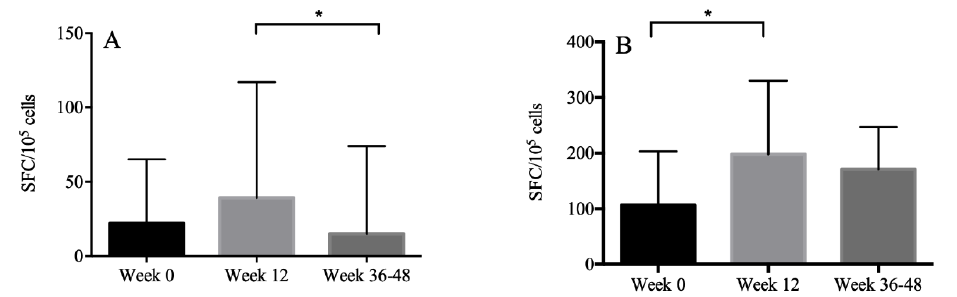
Figure 2. The magnitude of the IFN-r ( A ) and TNF-a ( B ) response to HBsAg presented with median and interquartile ranges. The level of IFN-r secreted at week 12 was higher than that at week 36, and the level of TNF-a secreted at week 12 was higher than that at week 0. *: p < 0.05. We further explored whether HBsAg-specific T cell responses corresponded with HBsAb titer. We found that there was no correlation between the magnitude of the IFN-r